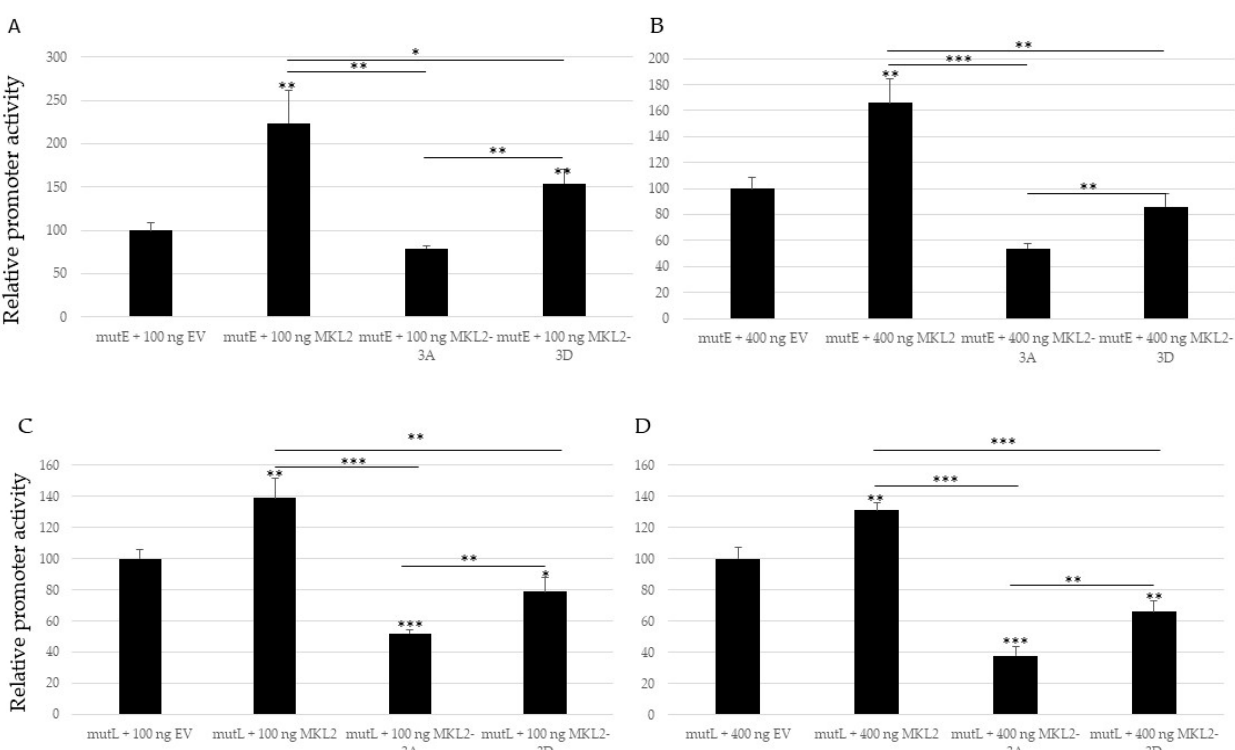
Figure 7. Alanine substitutions abrogate whereas aspartic acid replacements of the PKA phosphoacceptor residues restore MKL2 LTag’s ability to induce the MCPyV early and late promoter. HaCaT cells were co-transfected with a luciferase plasmid containing the non-replicative early promoter (mutE) and 100 ng ( A ) or 400 ng ( B ) expression plasmids. ( C ) and ( D ) as ( A ) and ( B ), respectively, but cells were transfected with a luciferase plasmid containing the MCPyV late promoter (mutL). Each bar represents the average of three independent parallels with standard deviation. Statistically significant differences with empty expression vector are indicated on top of the bar, whereas differences between MKL2 LTag and the mutants and between the 3A and 3D mutant are indicated on top of the horizontal lines (* p < 0.05; ** p < 0.01; and *** p < 0.001. Luciferase values were corrected for the protein concentration of the sample, and the corrected value for the empty vector was arbitrarily set as 100%.